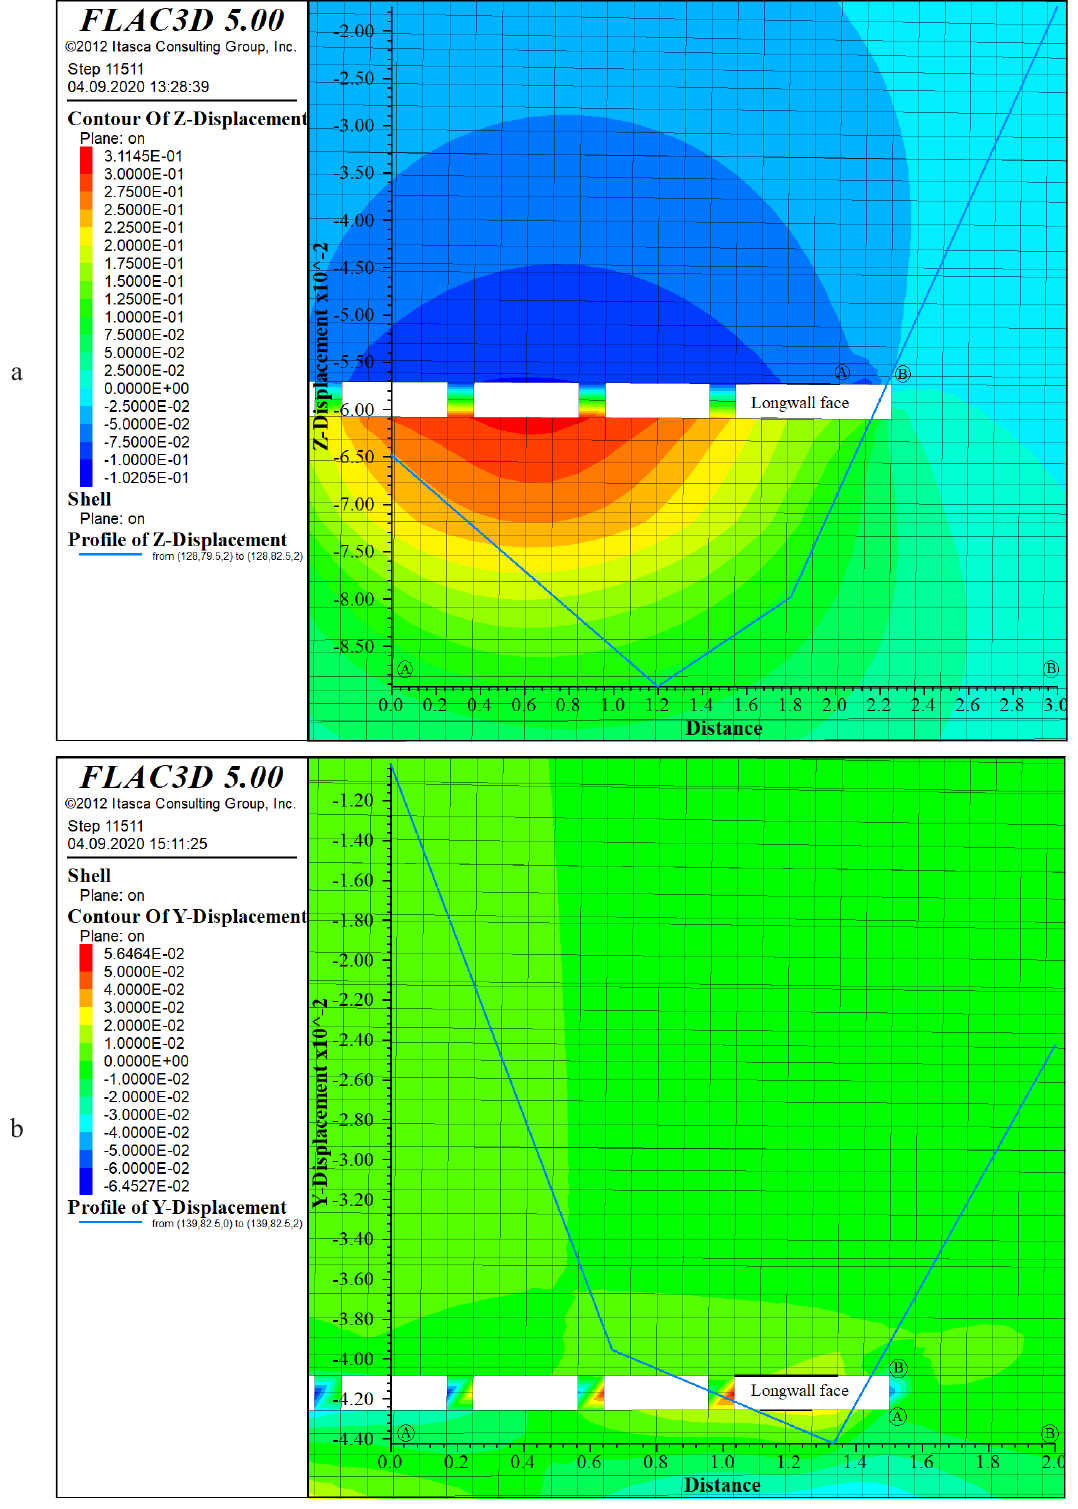
Figure 16: Displacement around the longwall face using the strain-softening model: a) vertical displacement along the tip-to-face distance, b) horizontal displacement along the longwall